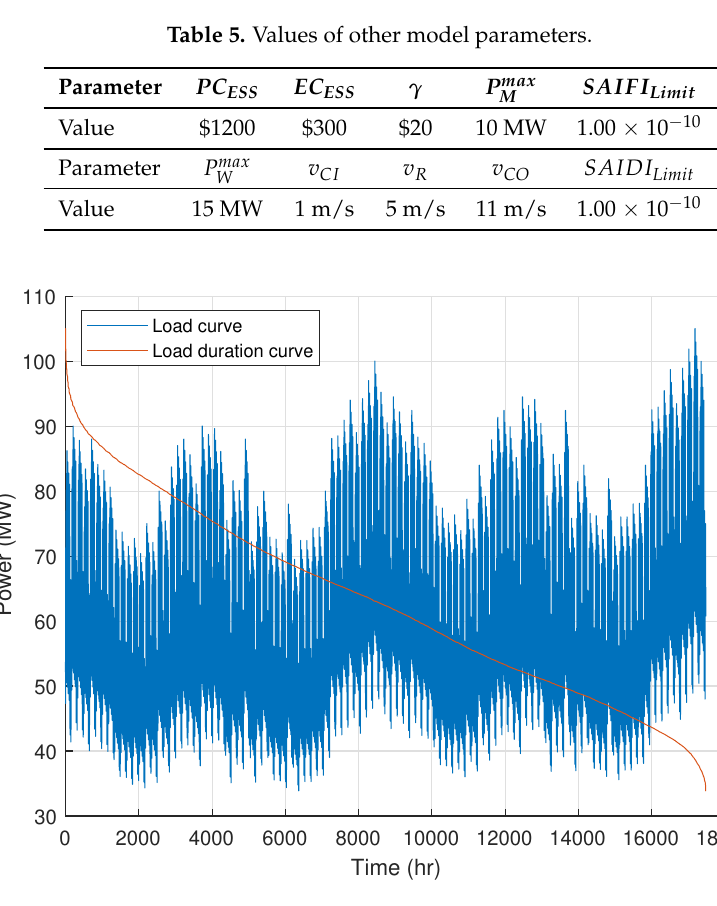
Figure 9. Load curve and load duration